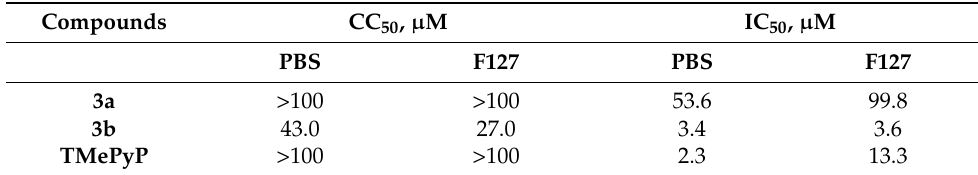
Table 2. CC 50 and IC 50 values of porphyrins dissolved in phosphate-buffered saline (PBS) or Pluronic F-127.